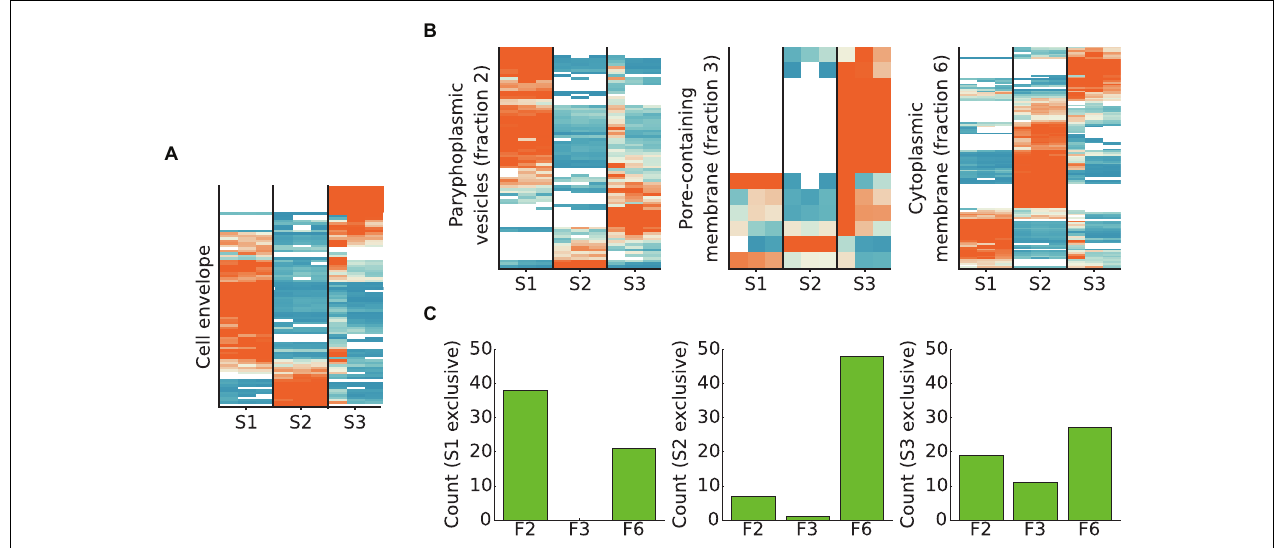
FIGURE 8 | Subcellular fractionation profiles of T. immobilis cell envelope proteins and homologs of proteins identified in membrane proteomes of G. obscuriglobus . (A) Relative abundance and subcellular fractionation profiles of 89 proteins from the cell wall proteome of T. immobilis (Mahajan et al., 2020a). (B) For proteins unique to each G. obscuriglobus membrane fraction (paryphoplamsic vesicles (fraction 2), nuclear-pore containing membrane (fraction 3) and cytoplasmic membrane fraction (fraction 6) (Sagulenko et al., 2017), the relative abundance of identified T. immobilis homologs is shown as a function of the respective subcellular fraction [Tris soluble (S1), Tris/TX-100 soluble (S2), and Tris/SDS soluble (S3)]. Heatmaps in (A) and (B) are colored according to scale in Figure 4 . ( C ) Barplot illustrating the number of fraction-specific proteins from T. immobilis [Tris soluble (S1), Tris/TX-100 soluble (S2), and Tris/SDS soluble (S3)] as a function of the membrane fraction of the corresponding homologs in G. obscuriglobus (F2: paryphoplamsic vesicles, F3: nuclear-pore containing membrane, F6: cytoplasmic membrane